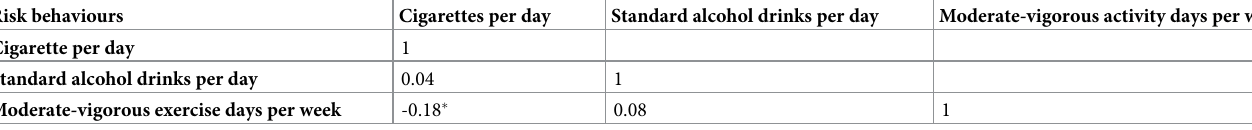
Table 3. Correlations of health-related